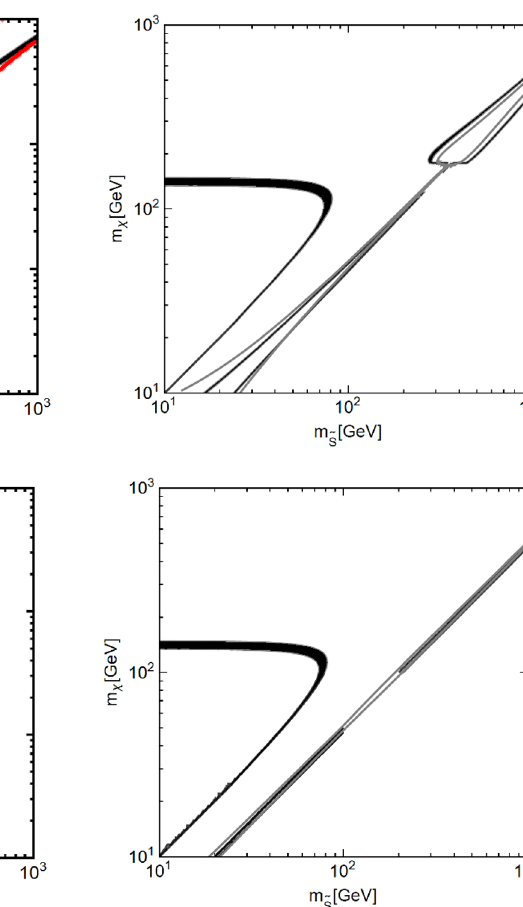
Figure 13 . Isocontours of correct relic abundance for the Yukawa (top), and gauge (bottom) portals with a pseudoscalar mediator. The left panels display the m (cid:31) (cid:0) coupling plane for m S = 100 GeV (black, solid) and m S = 500 GeV (red, dashed). The shaded regions correspond to the exclusion bounds from ID constraints. The plots in the right column show instead the m S (cid:0) m (cid:31) plane for y ~ = 1 and c ~ = 1 (top) and c ~ S = 1 (bottom). The regions inside the gray contours are excluded V S S by ID. For all plots we have set (cid:3) = 3